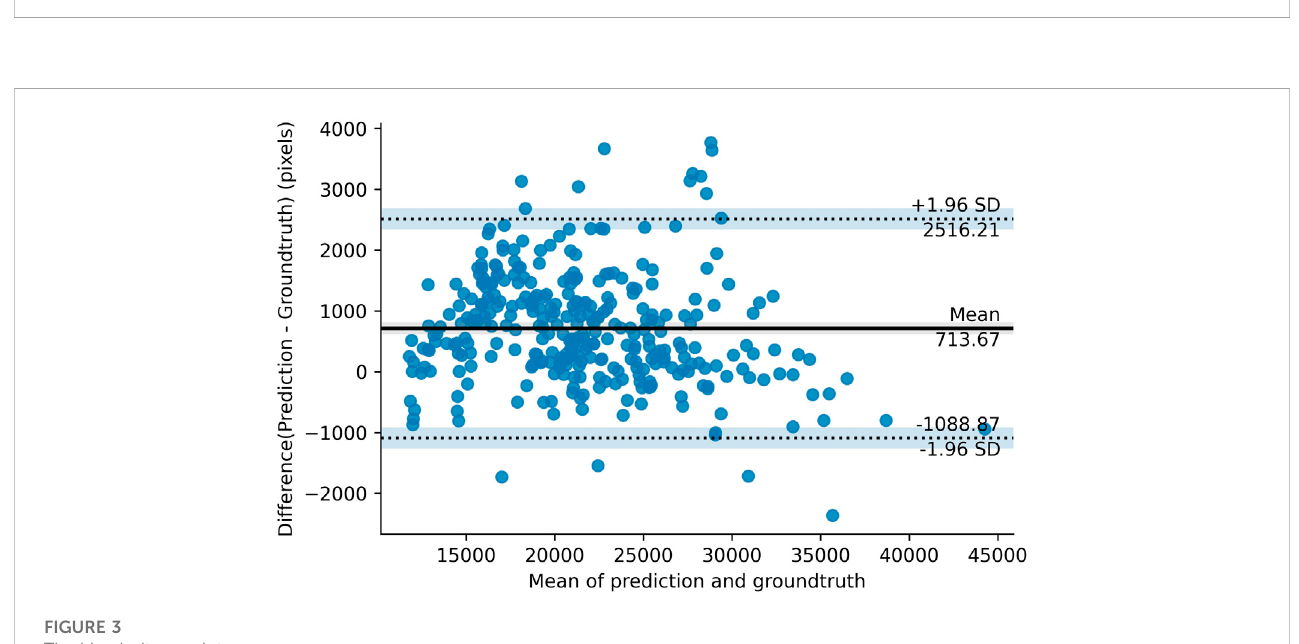
FIGURE 3 The bland-altman